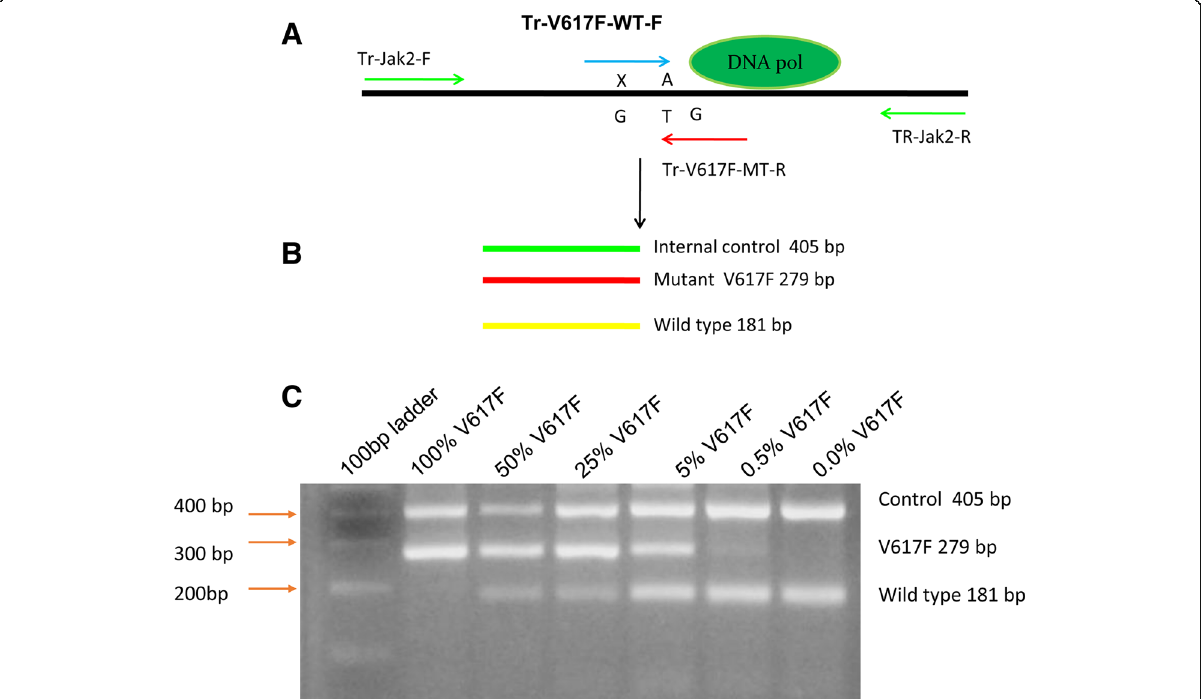
Fig. 3 Jak2 V617F screening by ARMS-PCR. Panel a with tetra primers: Jak2 V617F mutant allele amplified by primers (Tr-V617F-MT-R/Tr-Jak2-F) resulting in 279 bp product, whereas wild type allele amplified by primer pair (Tr-V617F-WT-F/TR-Jak2-R) resulting in 181 bp product. The amplicon produced by two outer primer pairs (Tr-Jak2-F/TR-Jak2-R) result in 405 bp product (internal control). Panel b Visualization on an agarose gel with dilution series to show resolution of tetra primer PCR product: Upper internal control (405 bp), V617F mutant (279 bp) and the Jak2 wild type (181 bp). Detection is achieved in samples containing up to 0.5% V617F mutant